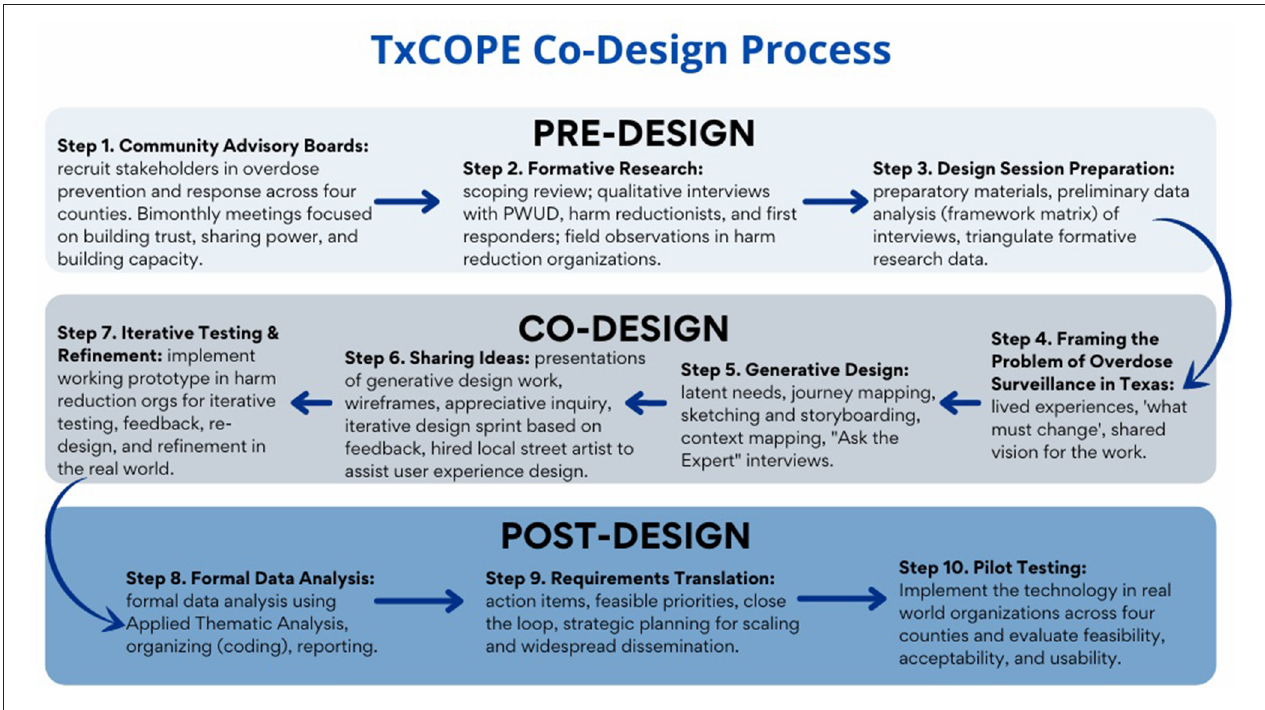
FIGURE 1 | Community-Academic technology co-design